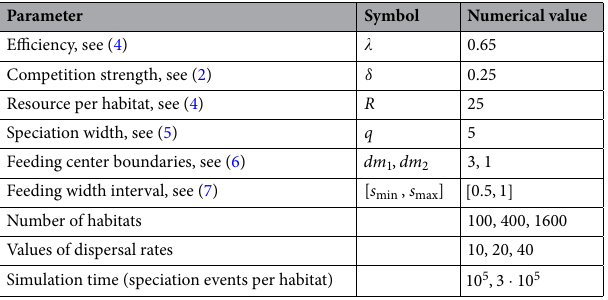
Table 1. Overview of model parameters with corresponding values used in simulations. Variable m in the feeding center definition refers to body mass of a